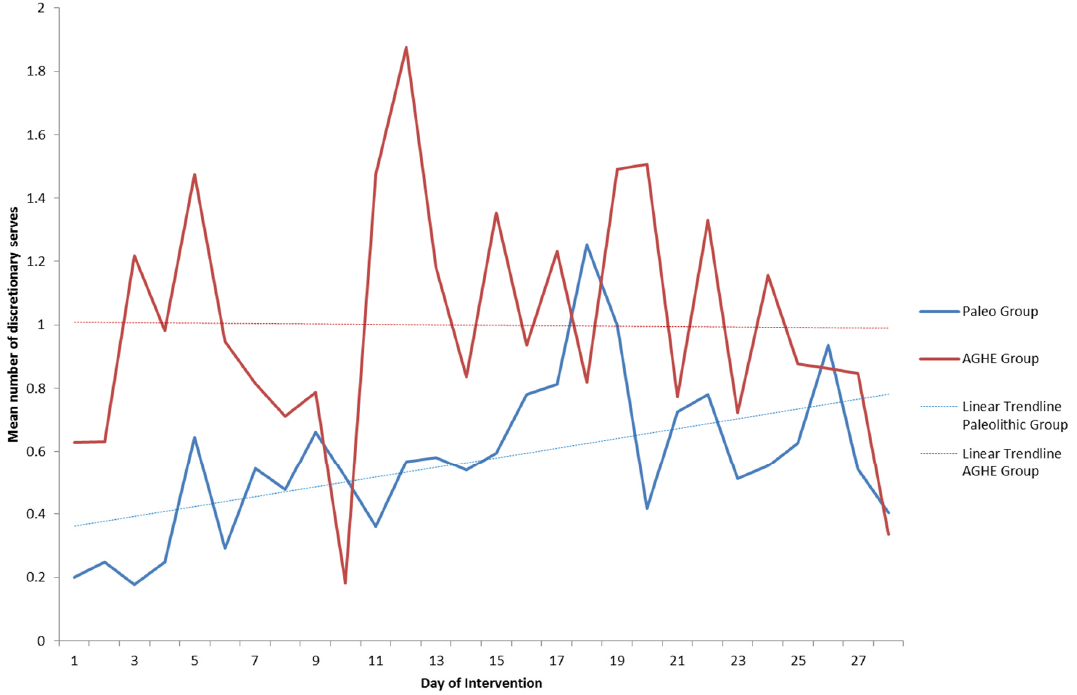
Figure 1. Compliance by day of intervention as measured by discretionary serve consumption.